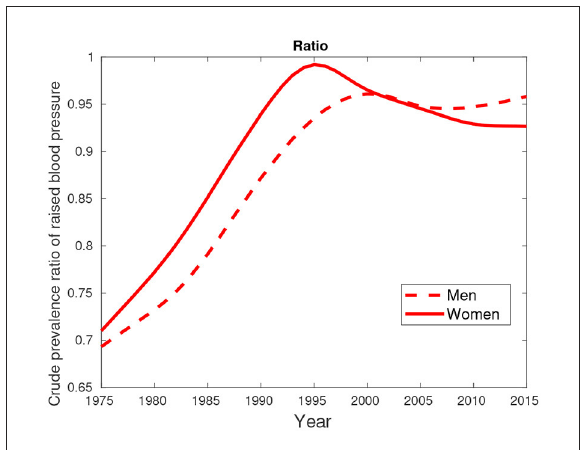
FIGURE9 Crude prevalence of raised blood pressure for male and female ratios between Botswana and South Africa from 1975 to